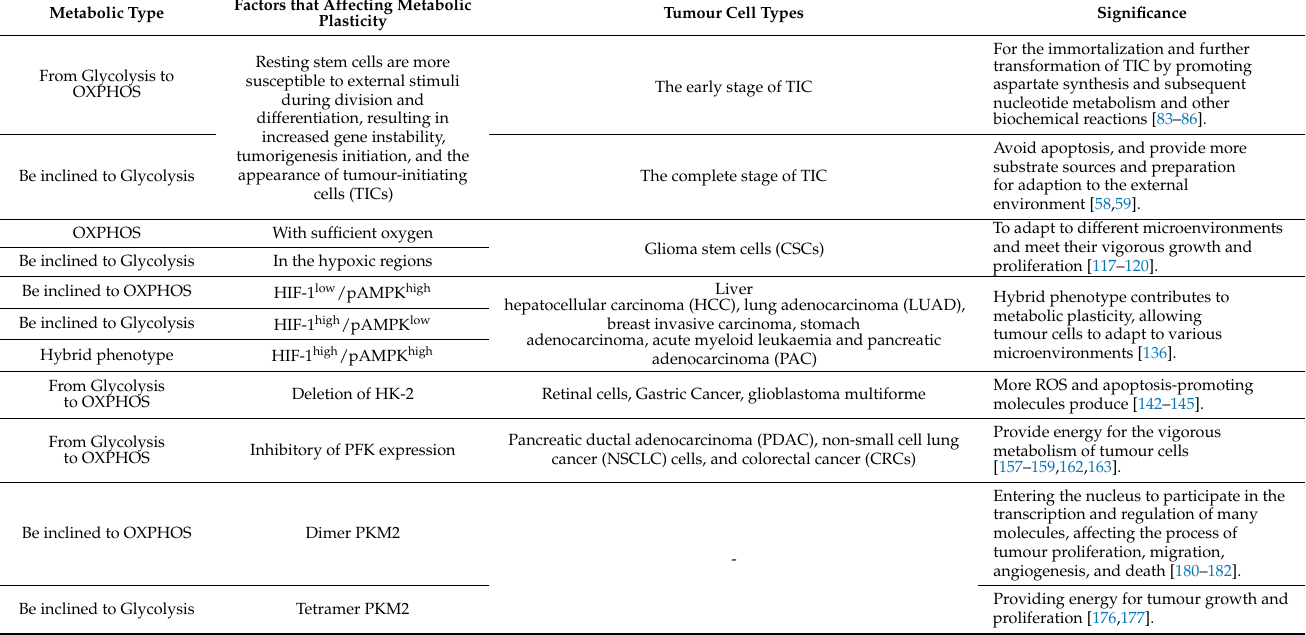
Table 2. Partial molecules that influence Metabolic plasticity